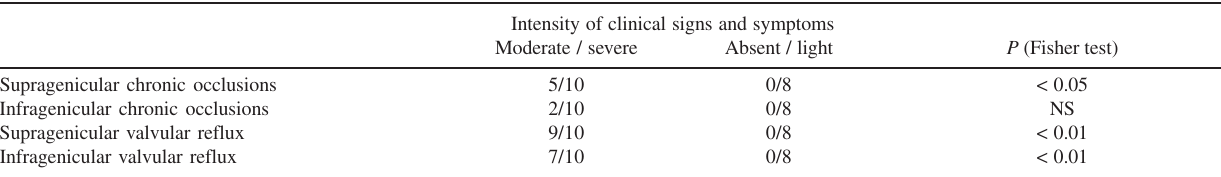
Table 6 - Association between the degree of late clinical signs and symptoms of PTS and final duplex-scan pathologic findings